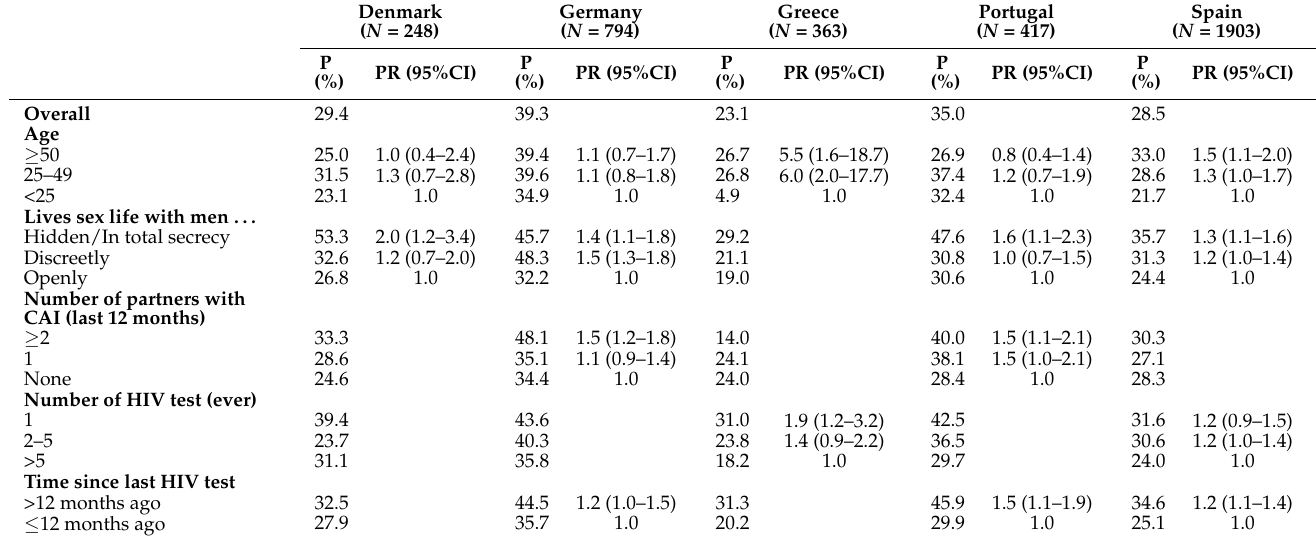
Table 2. Proportion of participants who chose self-testing as their preferred testing option (if all available) and associated